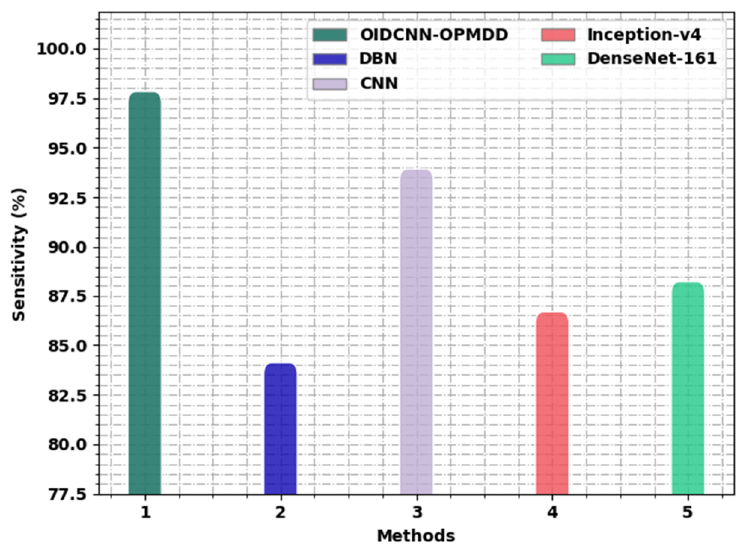
Figure 13. Sens y analysis of the OIDCNN-OPMDD approach with existing algorithms. Figure 13. Sens_y analysis of the OIDCNN-OPMDD approach with existing algorithms.